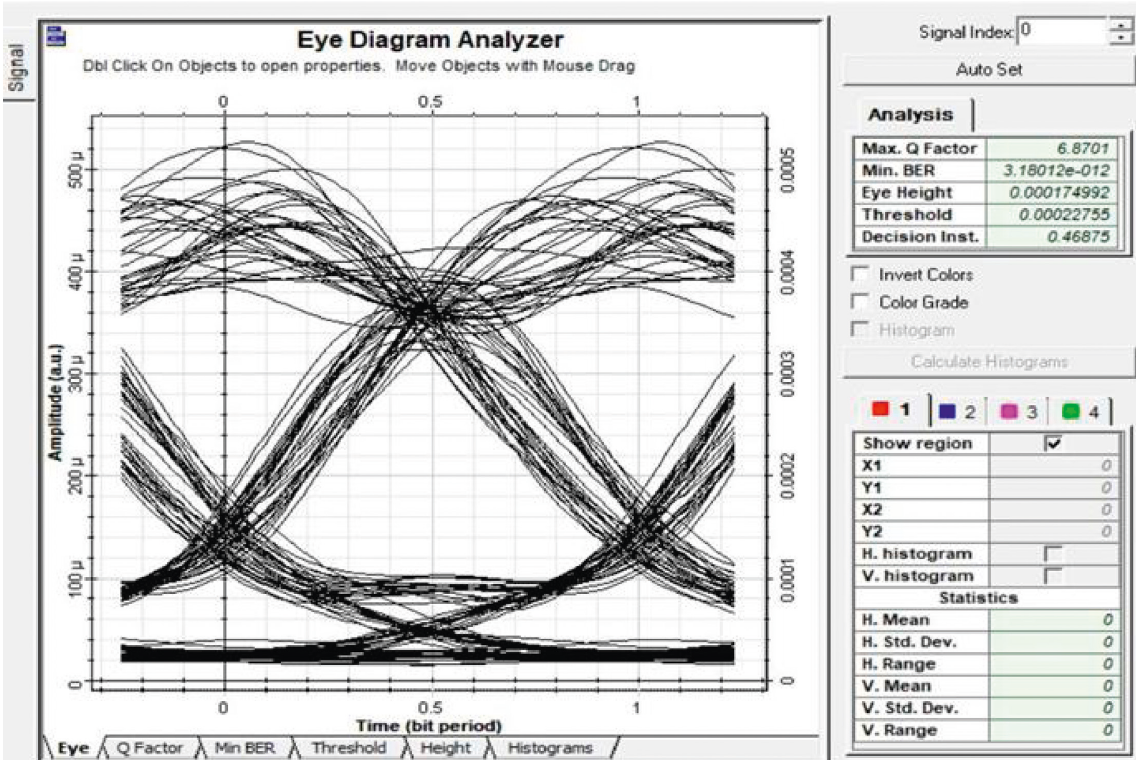
Figure 8: Eye-diagram graphs for double-stage Gaussian-apodized FBG+DCF